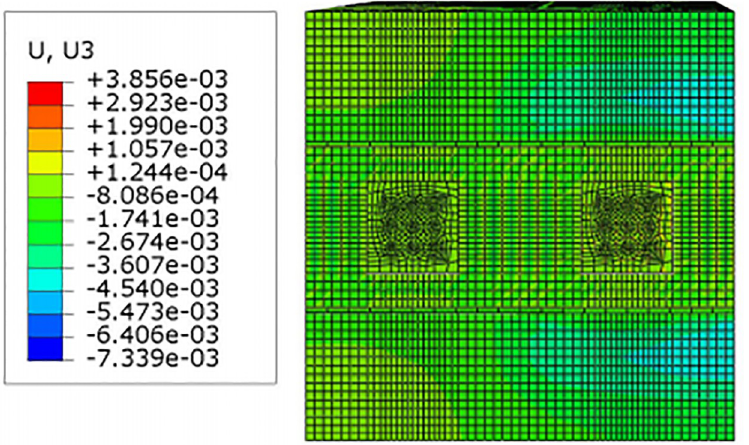
Fig 11. Model surface deformation clouds of loess-like soils at pipe jacking up to 10m.